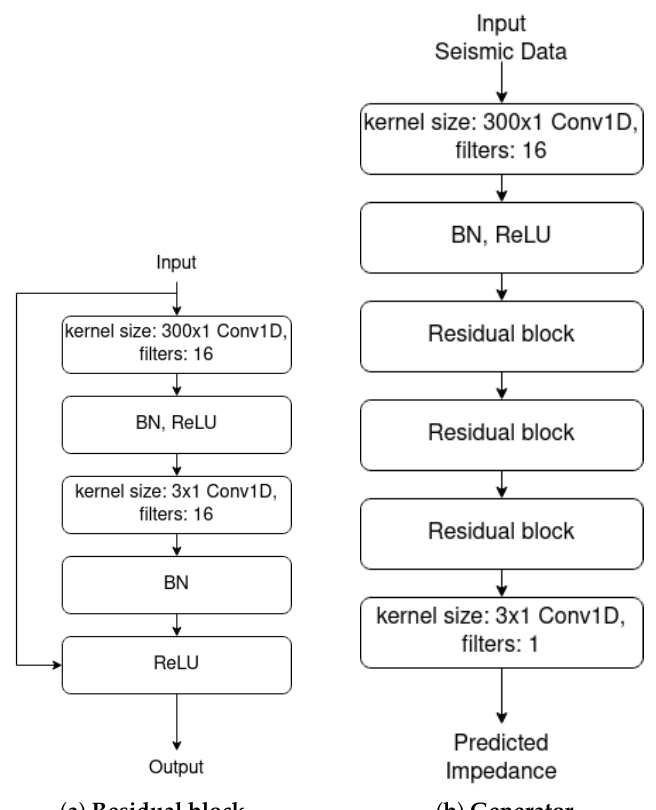
Figure 5. Architecture of a residual block and the generator. Source: adapted from